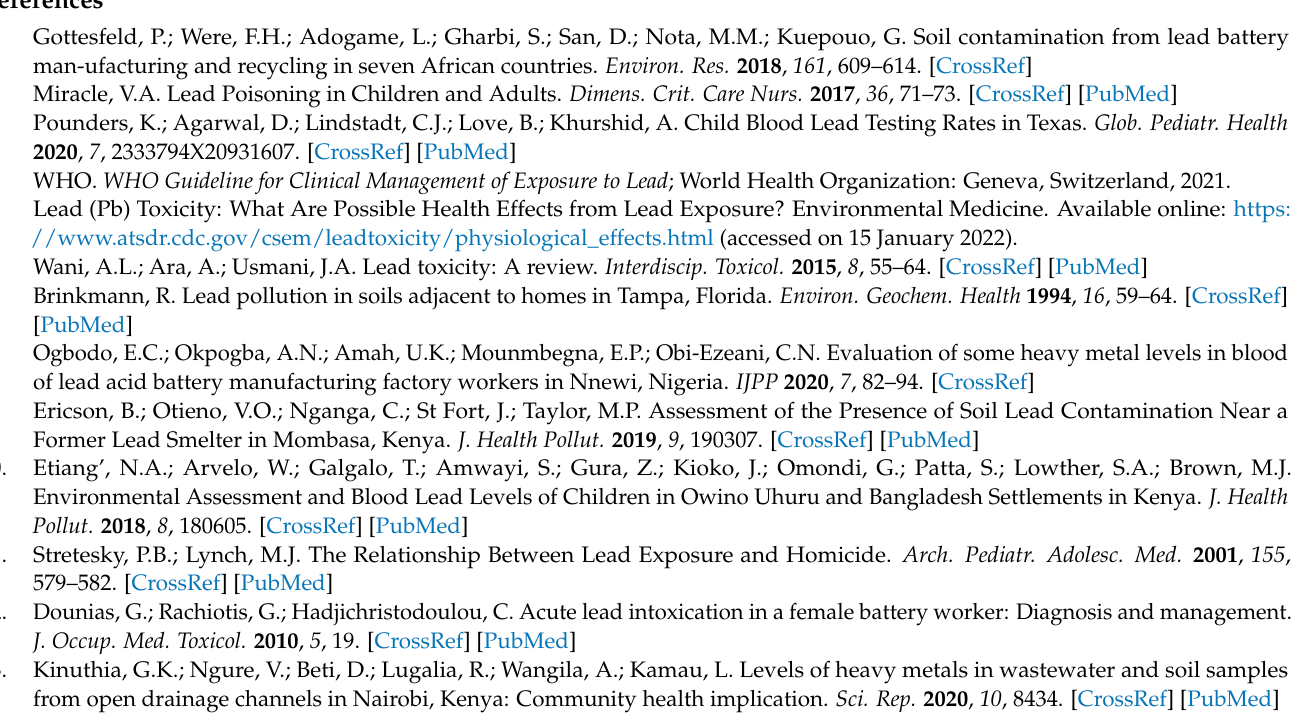
Table S2: The result of measurements of Lead (Pb) concentration in factory wastewater within the Associated Battery Manufacturing (East Africa). Table S3: The measurements of Lead (Pb) concentration in the plant extract in ppm within the Associated Battery Manufacturing (East